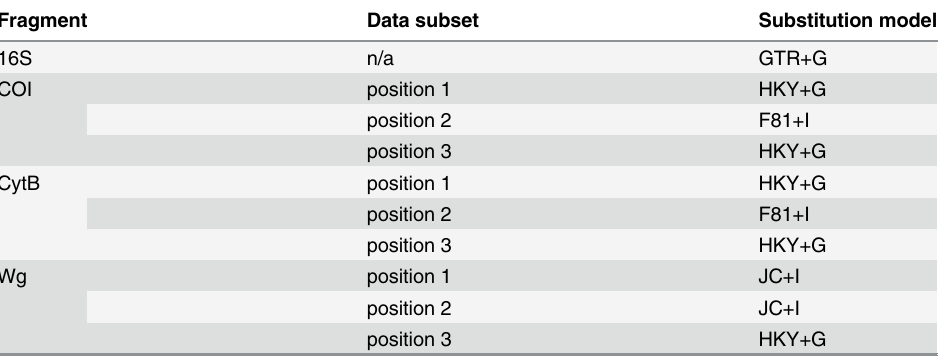
Table 2. Data partitions and nucleotide substitution models suggested by PartitionFinder